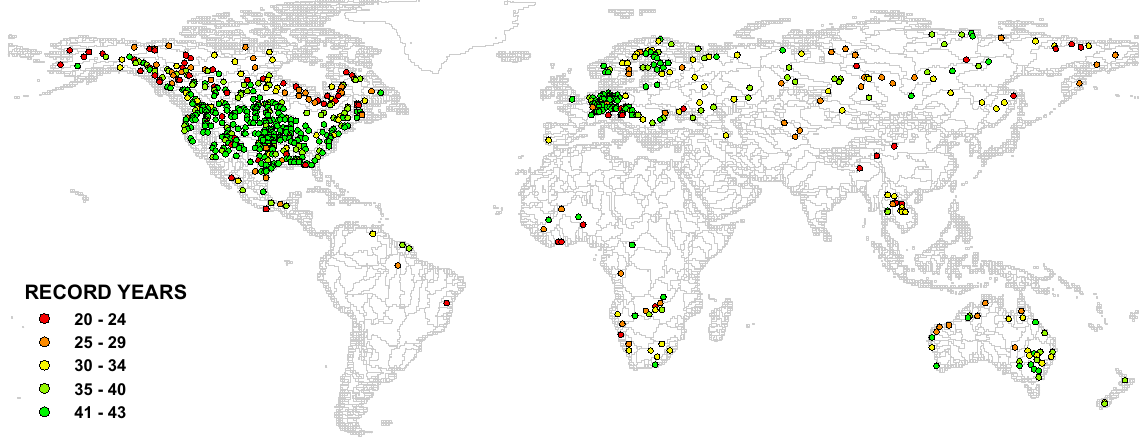
Figure 1. Location of 691 selected GRDC stations with the corresponding number of years per station. Background polygons are world sub-basins based on 30 (cid:48) drainage direction maps (Döll and Lehner, 2002) with separation of large basins (Ward et al.,